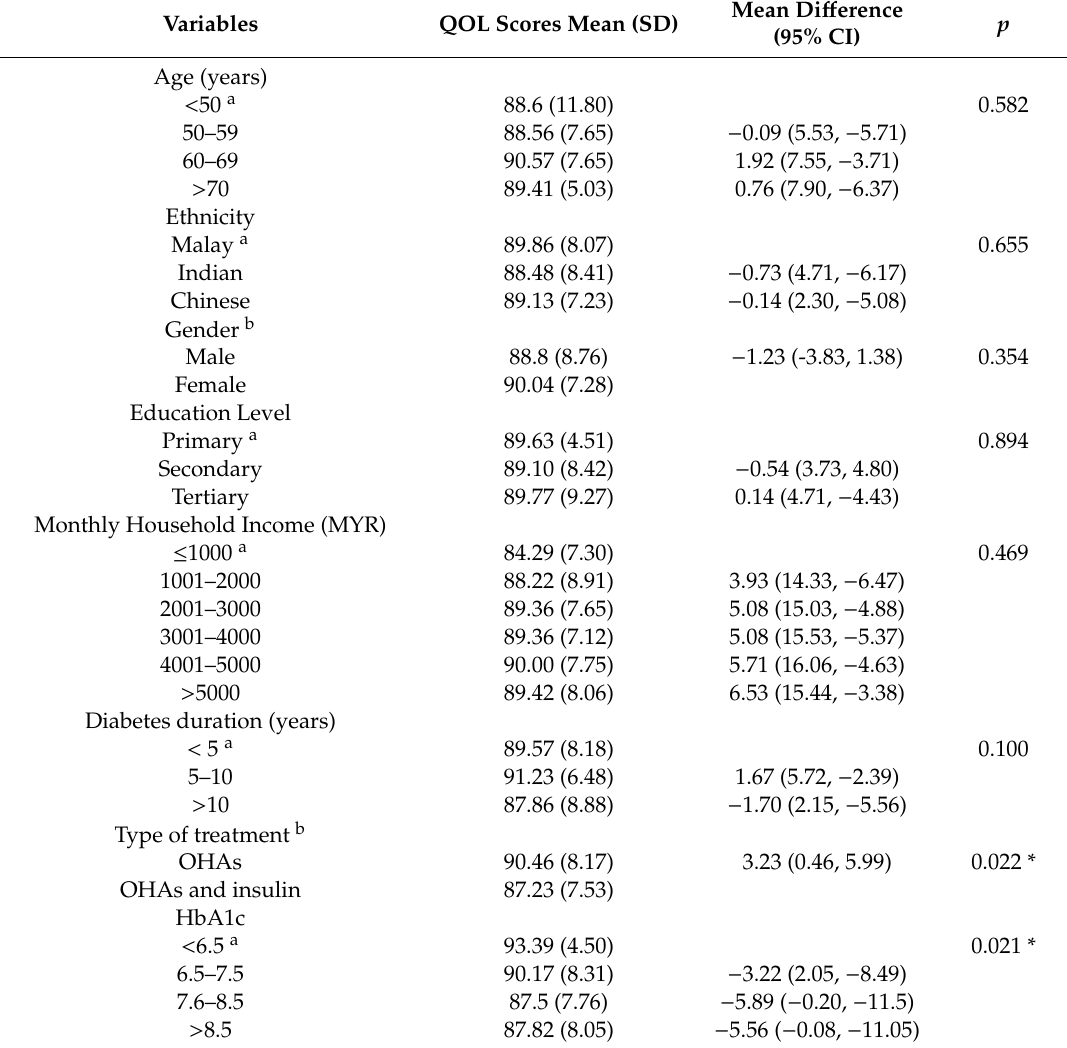
Table 2. Comparison of QOL scores according to characteristics of the study participants (n = 150). Variables QOL Scores Mean